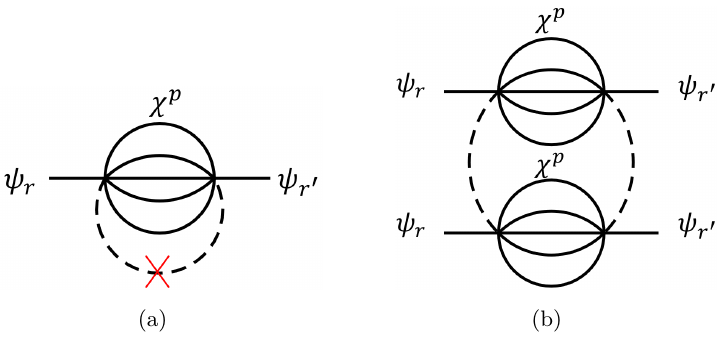
Figure 4 . (a) Under disorder average, the propagator between two local Majorana at r 6 = r 0 directly through the chaotic Majorana is zero. The dashed line represents disorder average over random variable V r,j (b) The variation of the propagator in 1 ,...,j p